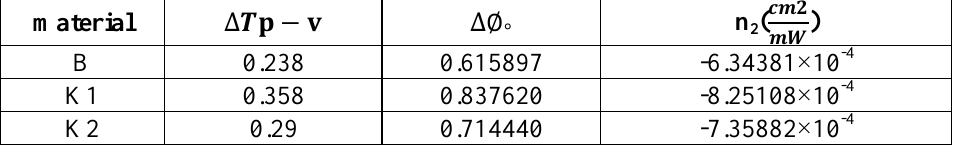
Table 3: The experimental results for the test samples in CA material